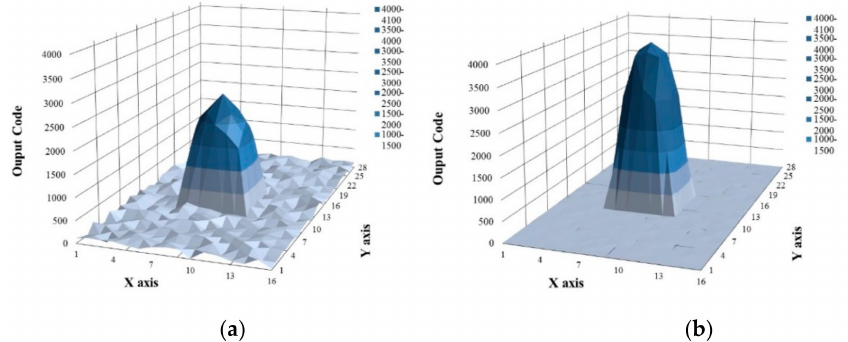
Figure 26. ( a ) Touch image before noise filtering, and ( b ) touch image after noise filtering.